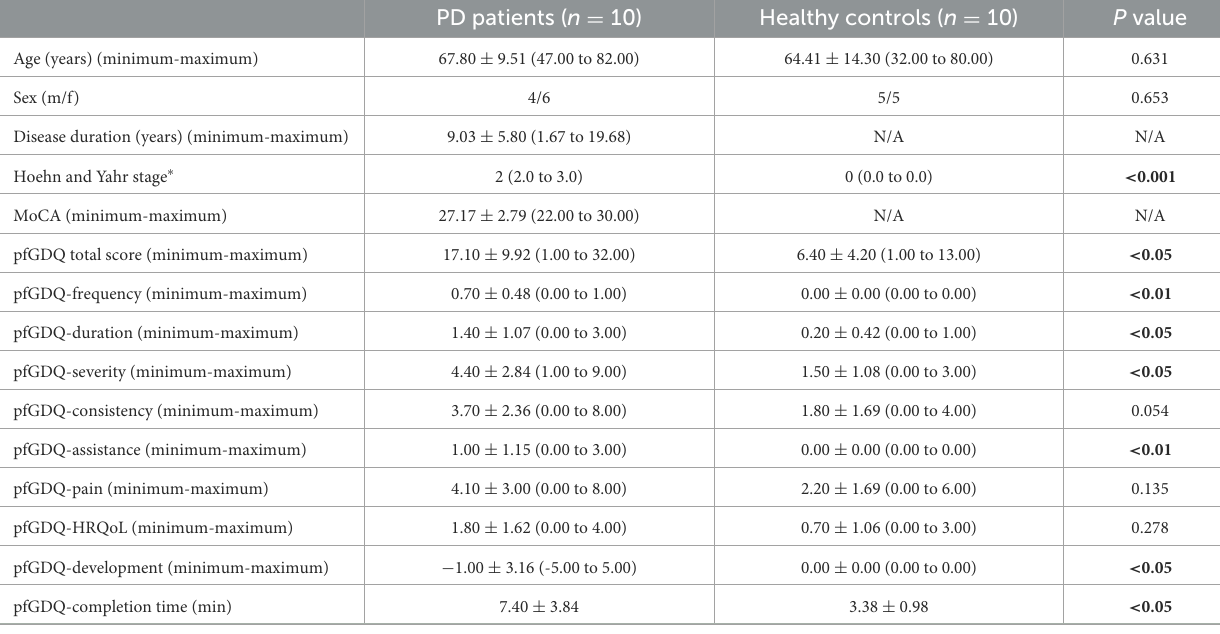
TABLE 6 Demographic, motor, and non-motor characteristics and prefinal GDQ score characteristics of patients with Parkinson’s disease and healthy controls of the phase 2b study. PD patients ( n =